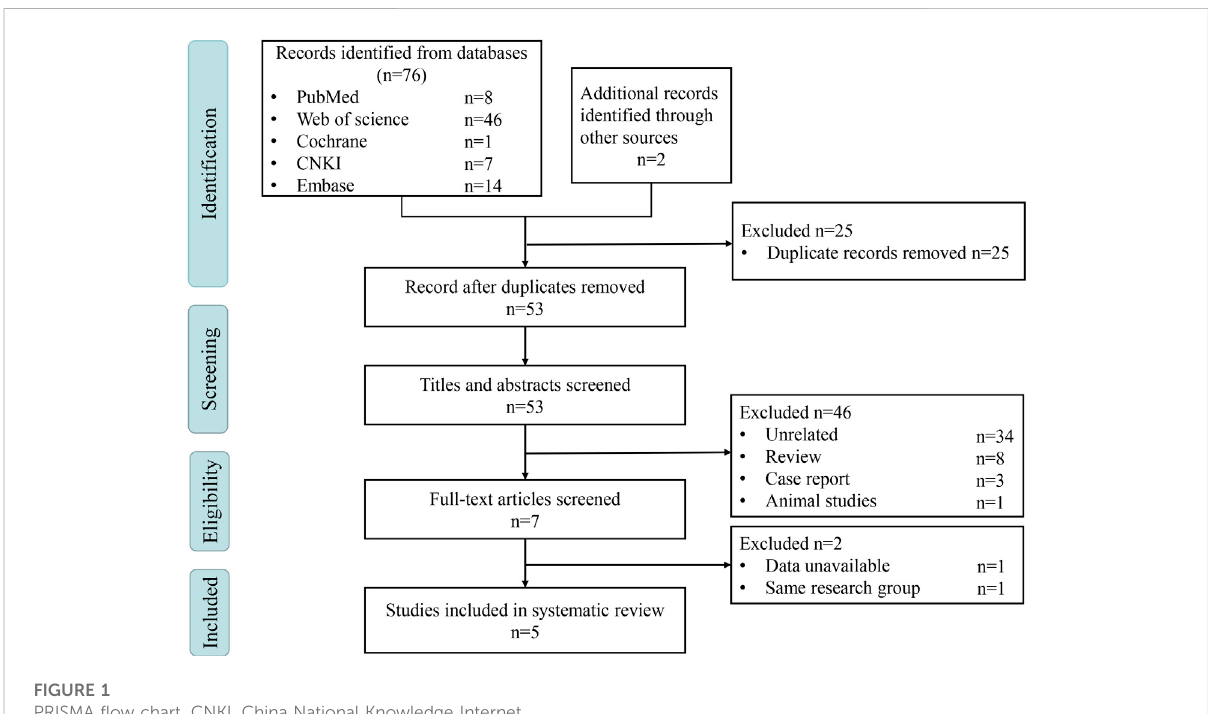
FIGURE 1 PRISMA fl ow chart. CNKI, China National Knowledge Internet.